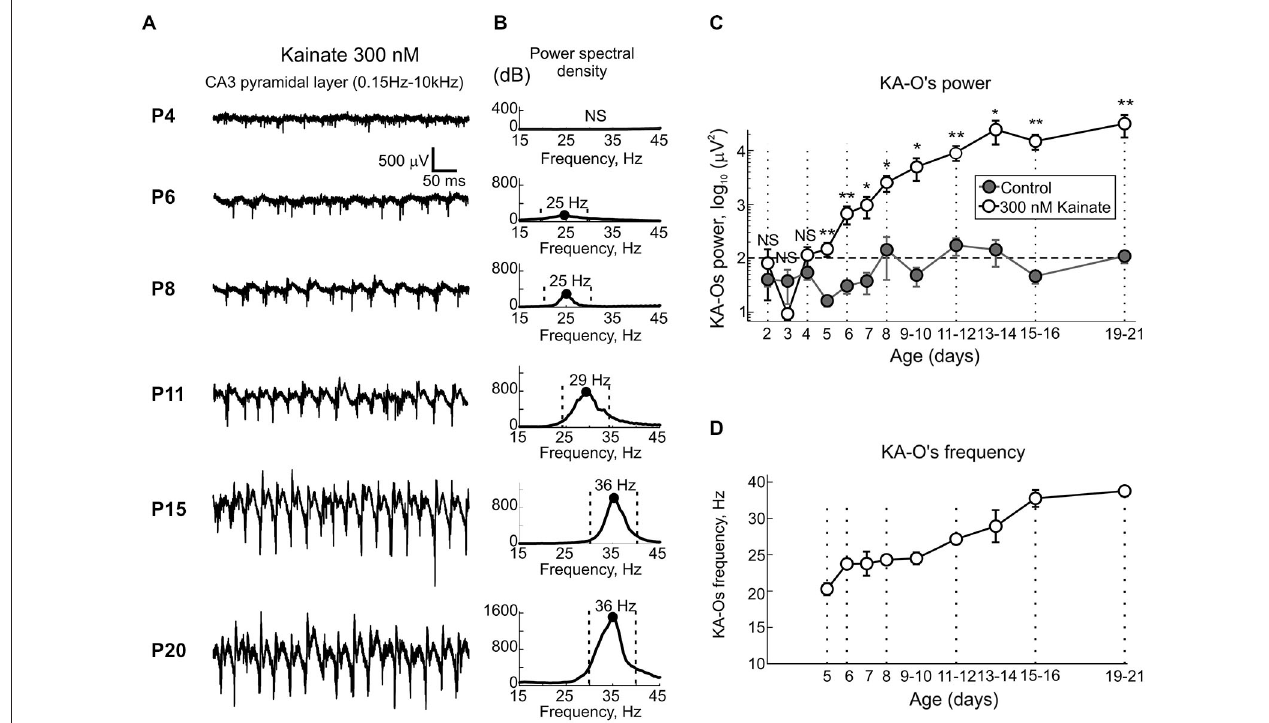
developmental increase in KA-Os’ power and frequency from beta to gamma frequency range through the period from P6 to P15. (C,D) Postnatal changes in the integral KA-Os’ power (C) and frequency (D) . Integral KA-Os’ power was calculated within peak ± 10 Hz frequency band as shown on (B) . Note that before P5, local field potential (LFP) power in the presence of kainate does not significantly exceed the power of baseline activity ( gray ) and builds up to attain a steady level by the end of the first postnatal week. Note also that KA-Os are initially slow, lying within beta frequency range (20–25 Hz) but progressively increase in frequency to attain gamma frequency values by the end of the second postnatal week. (C,D) Pooled data from n = 119 slices obtained from n = 51 P2–21 animals. Error bars indicate SE. Hereafter *= P < 0.05, **= P <